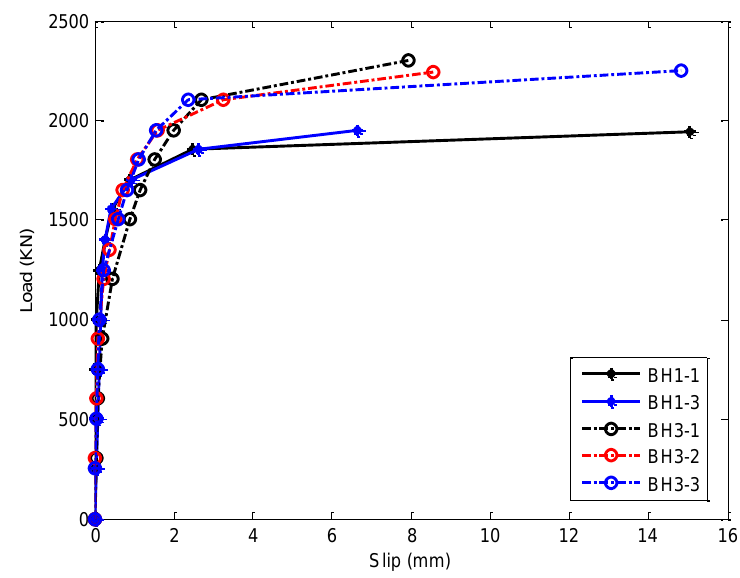
Figure 6. Load – slip relationship. Figure 6. Load–slip relationship. Figure 6. Load–slip relationship.